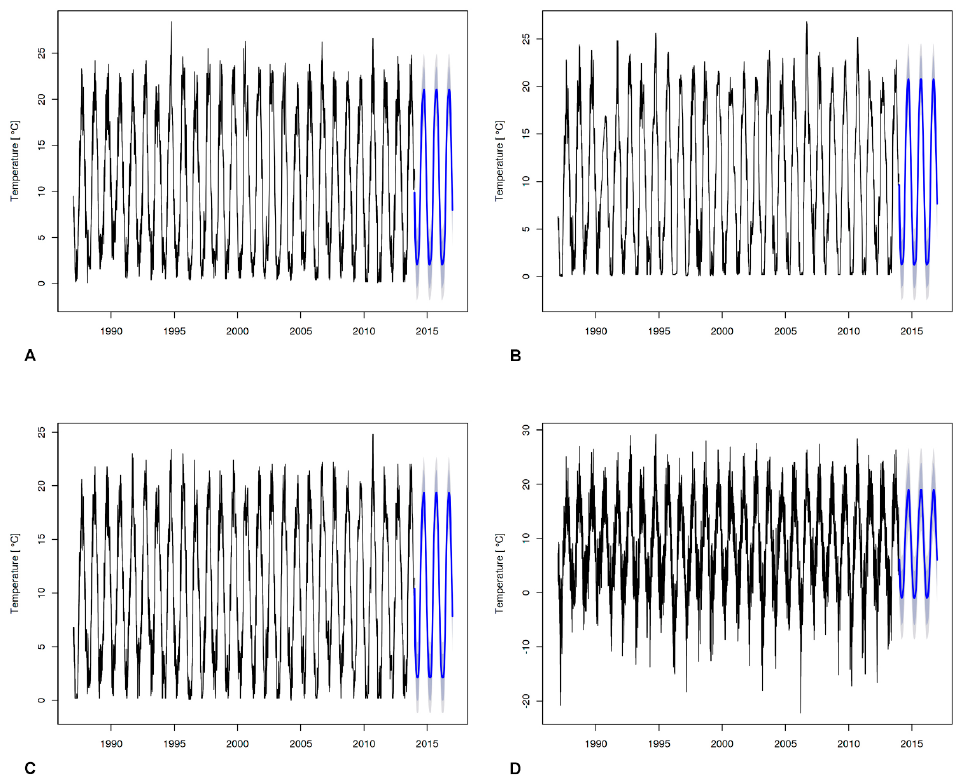
Figure 9. Modelling of the seasonality of annual temperature of river water and air using a fourth-order Fourier series with a prediction: ( A ) Note ć –Pako ść , ( B ) Note ć –Uj ś cie, ( C ) Note ć –Nowe Drezdenko, ( D ) Pi ł a (air temperature). The blue colour it is the predicted data.